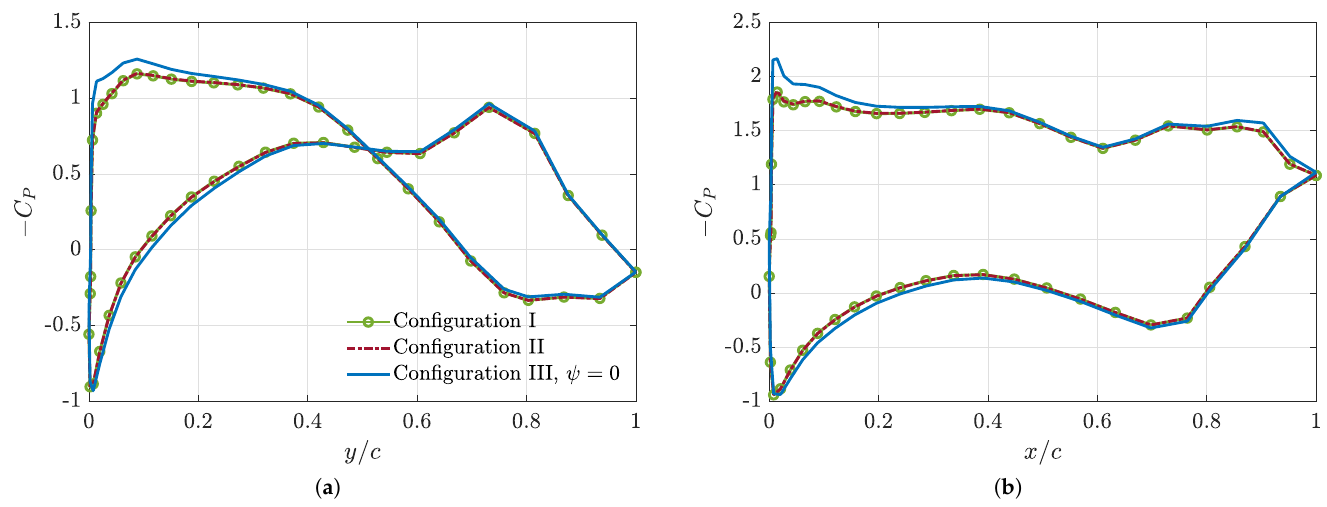
Figure 22. C P distribution at flaperon mid-span for the three configurations at bank angle φ = 30°. ( a ) C P left wing; ( b ) C P right